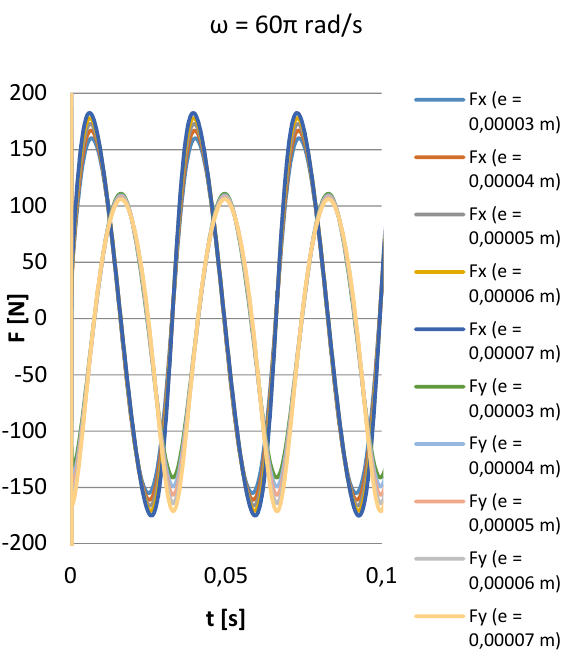
Fig. 4. Force components for ω = 60 π rad/s